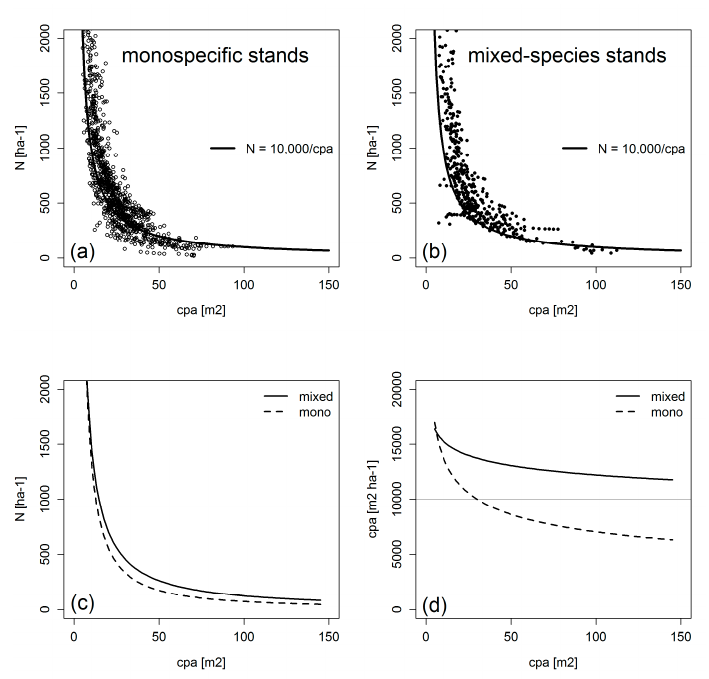
Figure 15. Relationship between tree number, N, and mean crown projection area, cpa, shown for ( a ) monospecific stands of Norway spruce, Douglas-fir, Scots pine, European beech, and sessile oak and for ( b ) mixed-species stands of the same species on similar sites. The black curve reflects the theoretical reciprocal relationship N = 10,000/cpa. ( c ) The mean N-cpa was higher and shallower for mixed compared to mono-specific stands. ( d ) The sum of crown projection areas per hectare was significantly higher (above one-fold coverage) in mixed stands but decreasing down to 2 / 3 coverage (7500 m 2 per ha-1) in the monospecific stands (see Table 1, model 9).